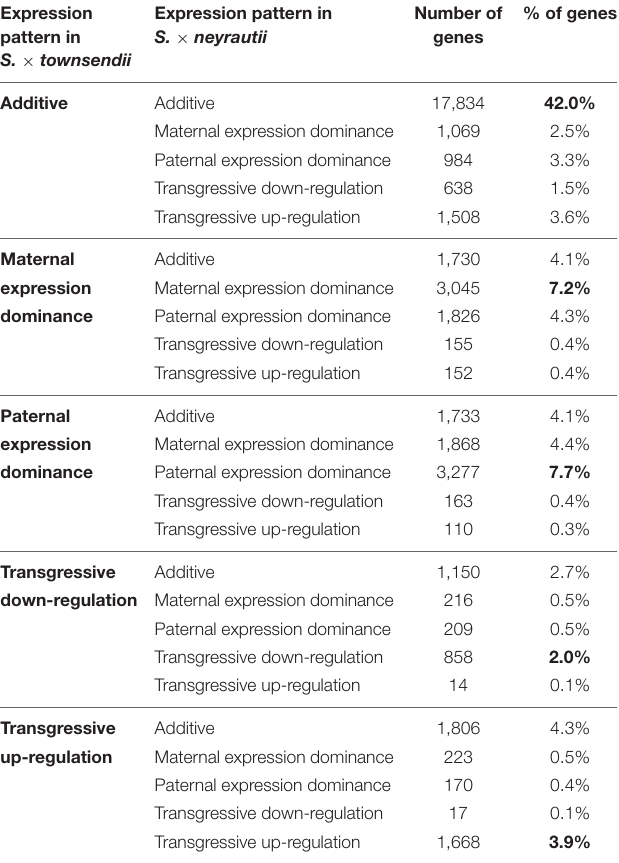
TABLE 4 | Gene expression pattern evolution in the two independently formed hybrids S. × townsendii and S. × neyrautii . Expression pattern